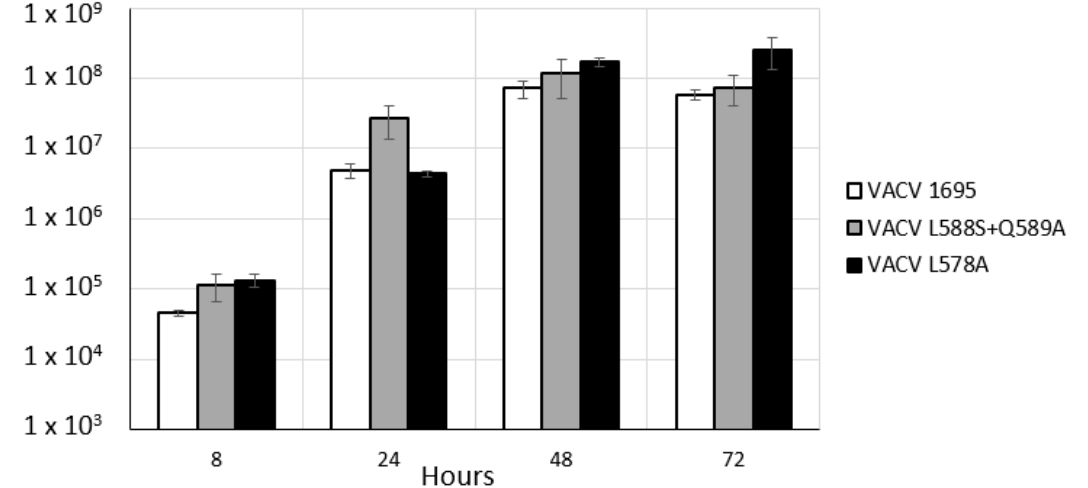
Figure 4. Growth properties of E9L mutant viruses. Vero cells were infected with the indicated viruses at an MOI of 0.05 and cultured at 37 °C. Virus yield was determined at each of the indicated time points, and is expressed in TCID 50 / mL . Results are expressed as the mean ± standard deviation for three experiments.